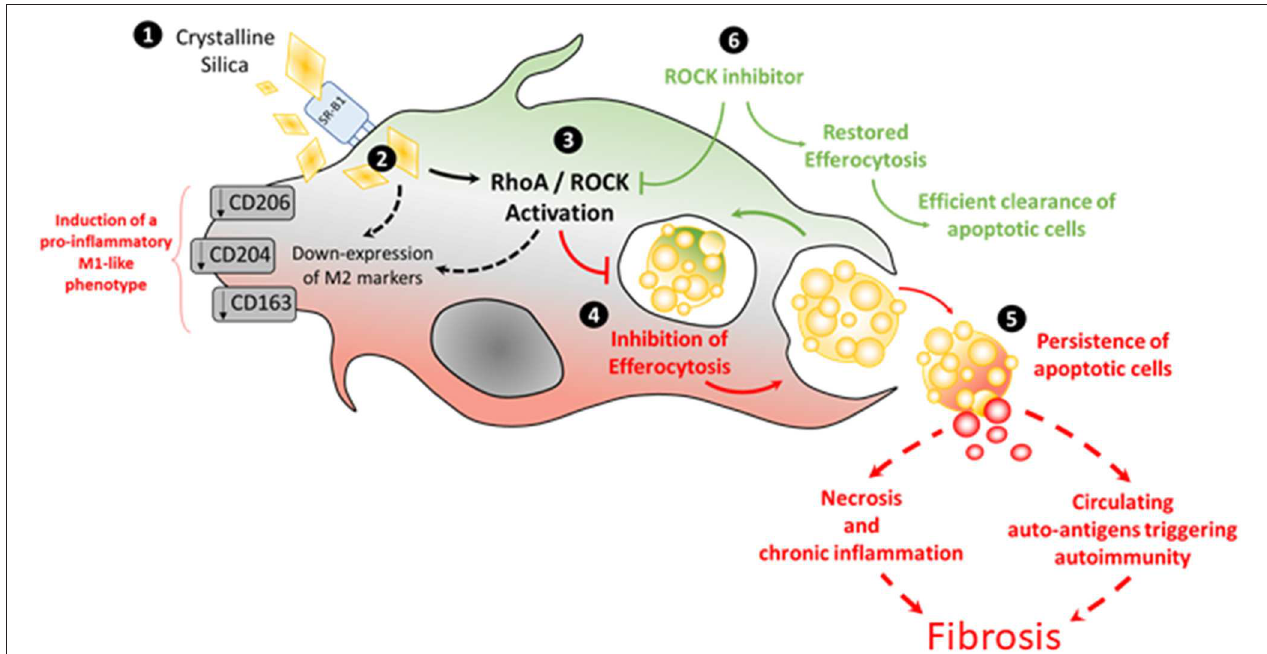
FIGURE 9 | Pathways involved in silica-impaired efferocytosis abilities of MDM [adapted from Lescoat et al. (38), license number: 4681481154582].